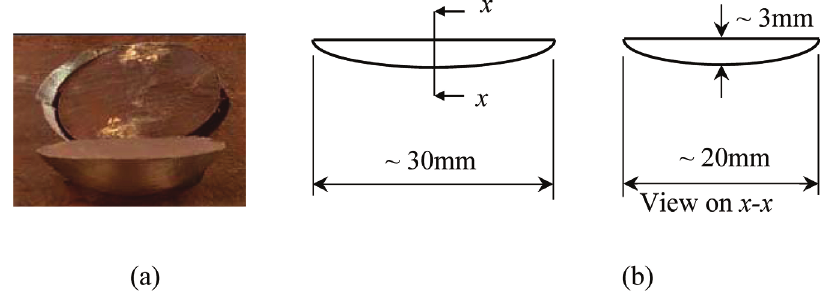
Figure 3: (a) Photograph of a scoop sample and (b) dimensions of a typical scoop sample.